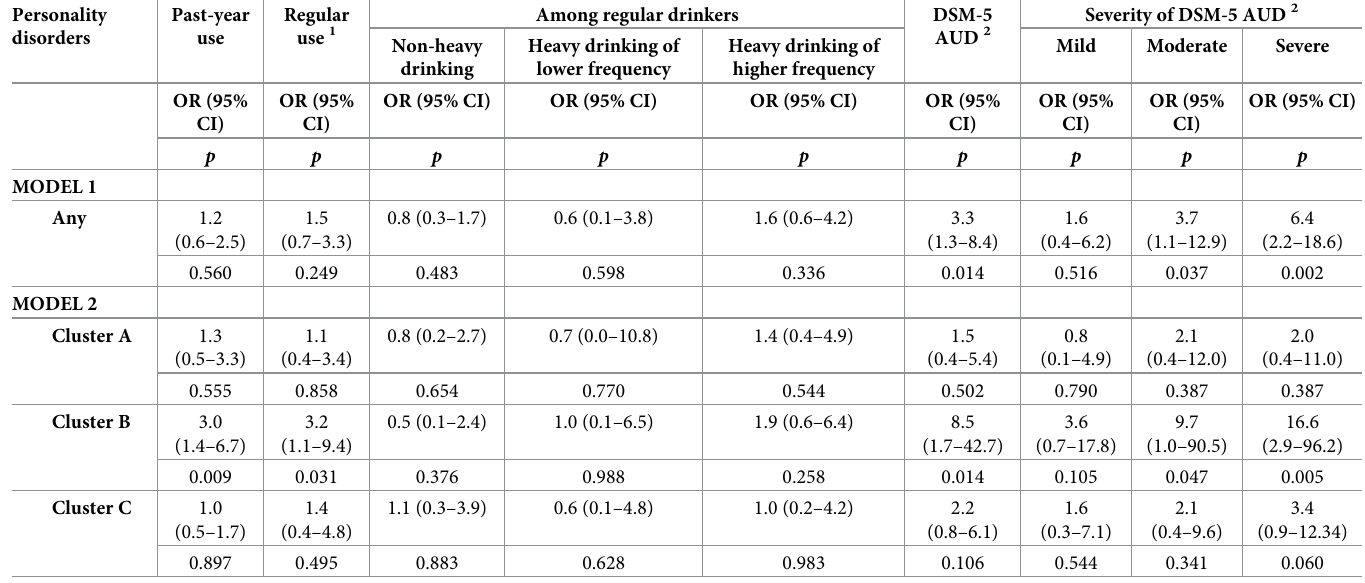
Table 3. Associations of personality disorders with past-year alcohol use, drinking patterns and alcohol-use disorder in the S ã o Paulo Metropolitan Area, Brazil (N =